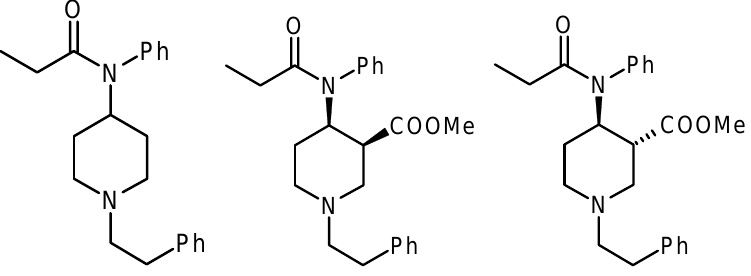
Figure 1. Fentanyl, (±) cis -3-carbomethoxyfentanyl and (±) trans -3-carbomethoxyfentanyl.